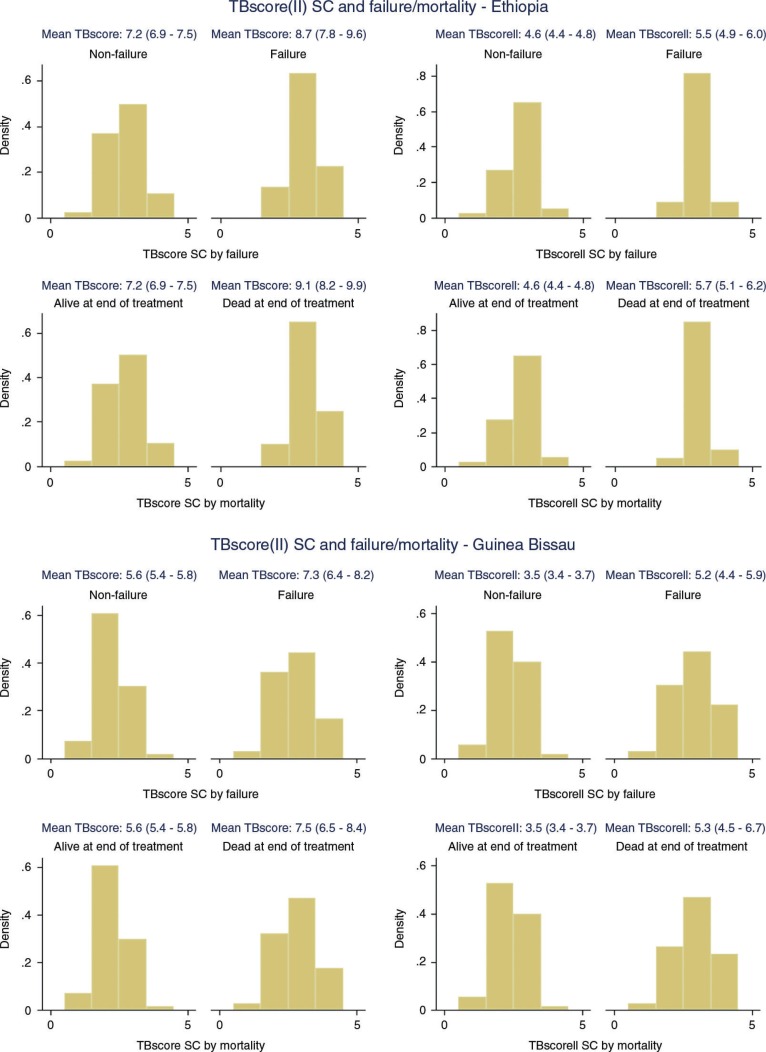
TBscore(II) at treatment start and subsequent failure/mortality.